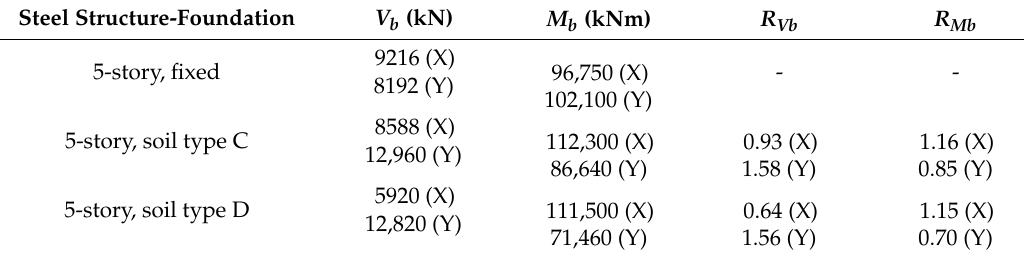
Table 10. Maximum V b , M b , and R values of the 5-story steel structure-foundation systems. Steel